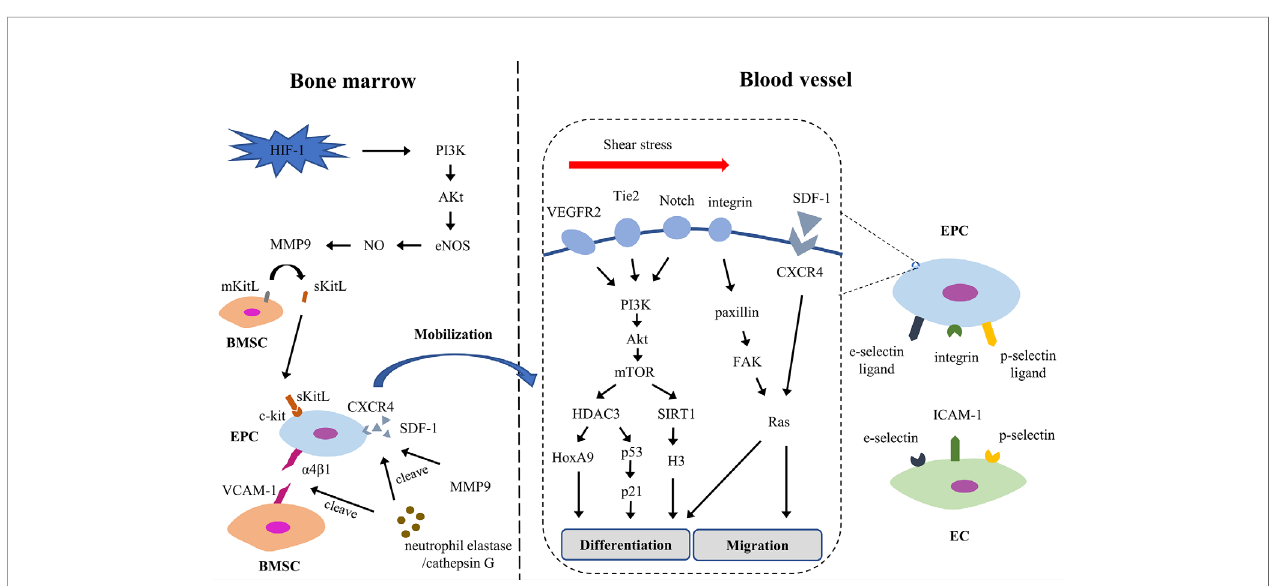
FIGURE 3 | The process of EPC re-endothelialization. Akt, Protein kinase B; BMSC, bone marrow stromal cell; CXCR4, chemokine (C-X-C motif) receptor 4; EC, endothelial cell; EPC, endothelial progenitor cell; eNOS, endothelial nitric oxide synthase; FAK, focal adhesion kinase; HDAC3, histone deacetylase 3; HIF-1, hypoxia- inducible factor 1; HoxA9, Homeobox A9; ICAM-1, intercellular adhesion molecule-1; mKitL, membrane-bound form of Kit ligand; MMP9, matrix metalloproteinase-9; mTOR, mammalian target of rapamycin; PI3K, phosphatidylinositol-3-kinase; SDF-1, stromal cell-derived factor-1; sKitL, soluble Kit-ligand; VCAM-1, vascular cell adhesion molecule-1; VEGFR2, vascular endothelial growth factor